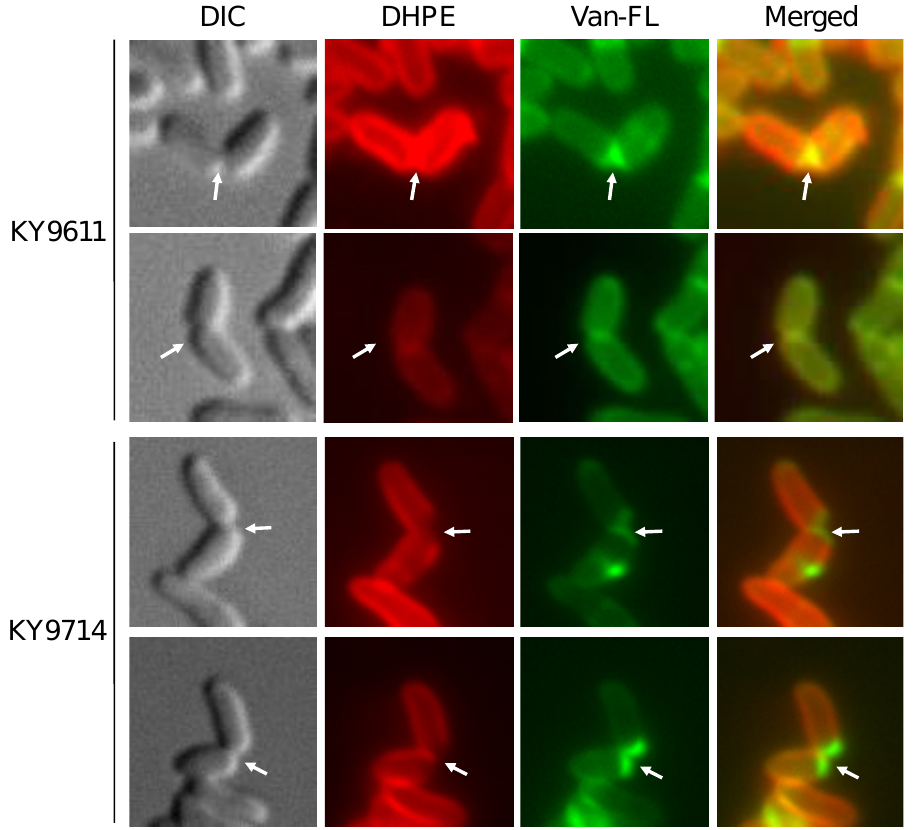
Figure 3. Microscopic observation of mycolic acid-containing layers at cell division sites in the C. glutamicum wild-type strain KY9611 and its ltsA mutant KY9714. Selective staining of mycolic acid-containing layers and peptidoglycan were performed using fluorescent probes, DHPE and Van-FL, respectively. Fluorescence images are shown in pseudocolor. Differential interference contrast (DIC) microscopic images are also presented. Arrows represent the cell division sites of C. glutamicum cells. Two sets of typical images for each strain are shown. A bar represents 2 µ